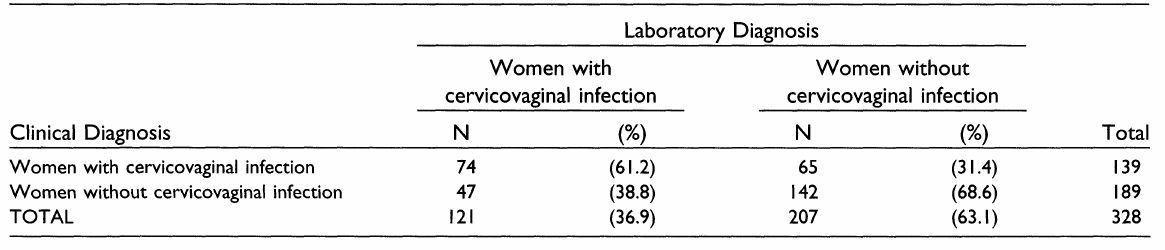
TABLE 3. Accuracy of the clinical diagnosis of cervicovaginal infections in 328 pregnant women (%) Infection Prevalence